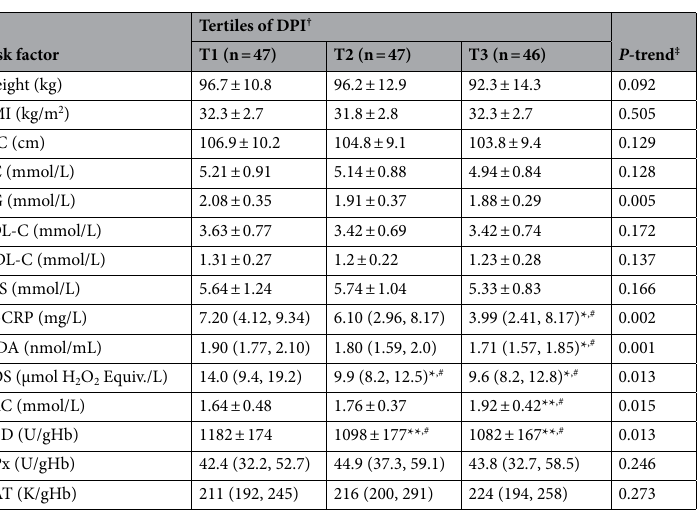
Table 3. Anthropometric indices and metabolic, inflammatory, and oxidative stress markers of subjects with obesity across tertiles of DPI. DPI dietary phytochemical index, TC total cholesterol, TG triglyceride, LDL- C low density lipoprotein cholesterol, HDL-C high density lipoprotein cholesterol, FBS fasting blood sugar, MDA malondialdehyde, TOS total oxidant status, TAC total antioxidant capacity, SOD superoxide dismutase, GPx glutathione peroxidase, CAT catalase, hs-CRP high-sensitive C-reactive protein. Values are expressed as mean ± standard deviation for normally distributed data (i.e . TC, TG, LDL-C, HDL-C, FBS, TAC, and SOD) and median (interquartile range) are presented for data not normally distributed (i.e . MDA, TOS, GPX, CAT, and hs-CRP). † Tertile cut-points of DPI are as follows: first tertile, < 27.3; second tertile, 27.3 to 33.9; third tertile, > 33.9. ‡ Obtained from analysis of variance (ANOVA) for normally distributed data (i.e. TC, TG, LDL- C, HDL-C, FBS, TAC, and SOD) and the non-parametric Kruskale-Wallis test for not normally distributed data (i.e. MDA, TOS, GPX, CAT, and hs-CRP). * P < 0.05 (Obtained from Dunn’s post hoc test). ** P < 0.05 (Obtained from Tukey post hoc test). # Significant difference from first tertile.